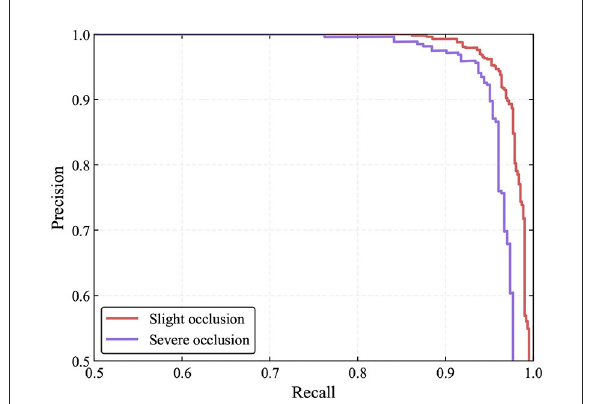
FIGURE13 PR curves of the proposed method under different occlusion conditions.